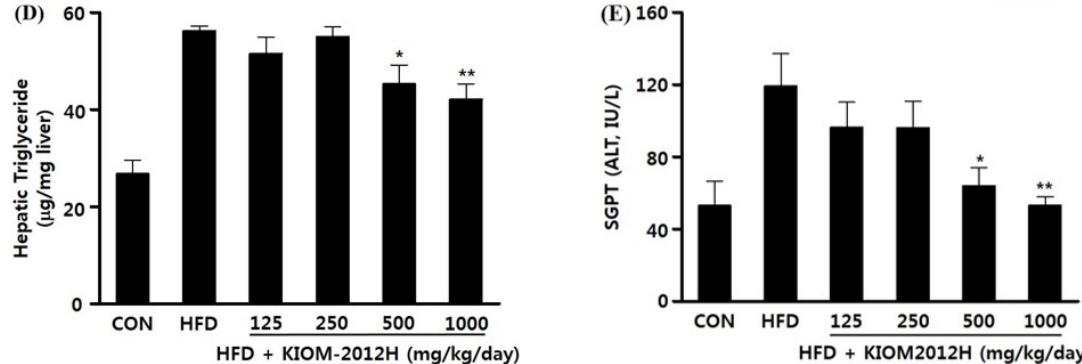
Figure 6. Livers from HFD-fed mice ( n = 13) show hypertrophy ( A ); absolute liver weight ( B ); relative liver weight ( C ); hepatic triglyceride content ( D ); and serum SGPT level ( E ); which were closer to normal for KIOM2012H. Statistical differences from HFD are indicated by asterisks ( * p < 0.05, ** p < 0.01).